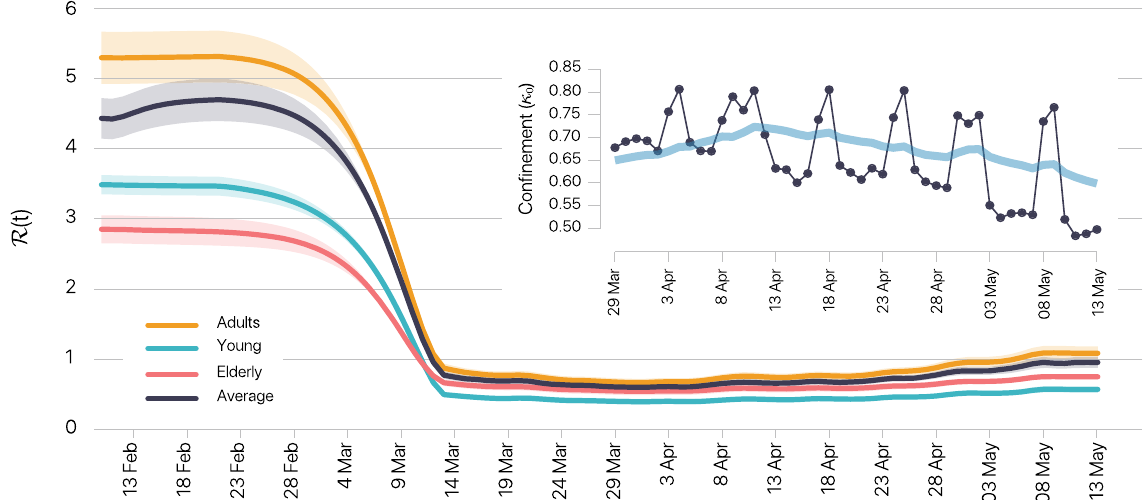
FIG. 3. Effect of lockdown policies on the effective reproduction number. Temporal evolution of the effective reproduction number R ð t Þ for each age stratum and its average computed according to Eq. (42). Inset: The black line represents the temporal evolution of the degree of confinement κ 0 ð t Þ extracted from data daily updated by INE [44]. The blue line shows the average over a 7-day time window to smooth out fluctuations observed in the data. To improve the visibility of the inset, degrees of confinement from March 14 until March 28 are not